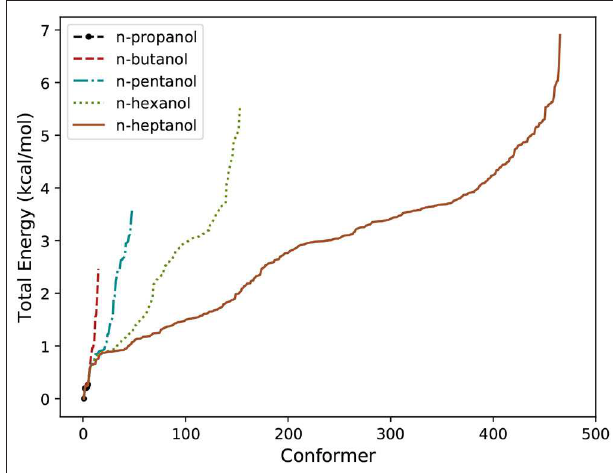
FIGURE 2 | Number of conformers of n-alcohols and their relative total